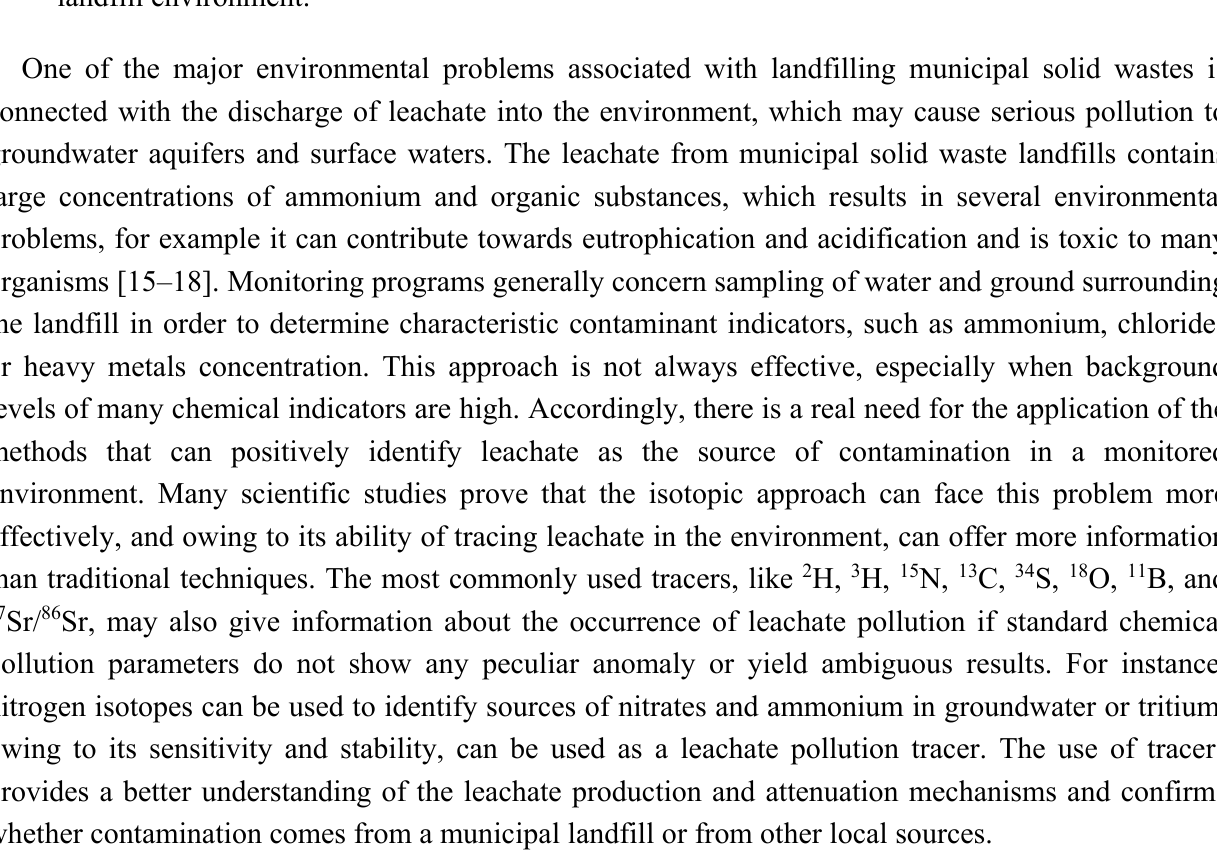
Figure 2. Potential nitrogen transformation pathways/nitrogen cycle that may occur in landfill